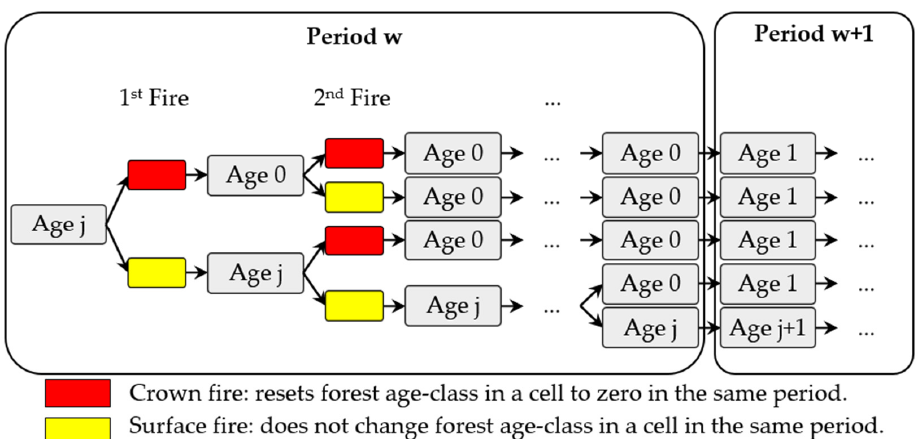
Figure 2. An example of the forest age-class transition for a cell in two planning periods under the influence of multiple wildfire events.